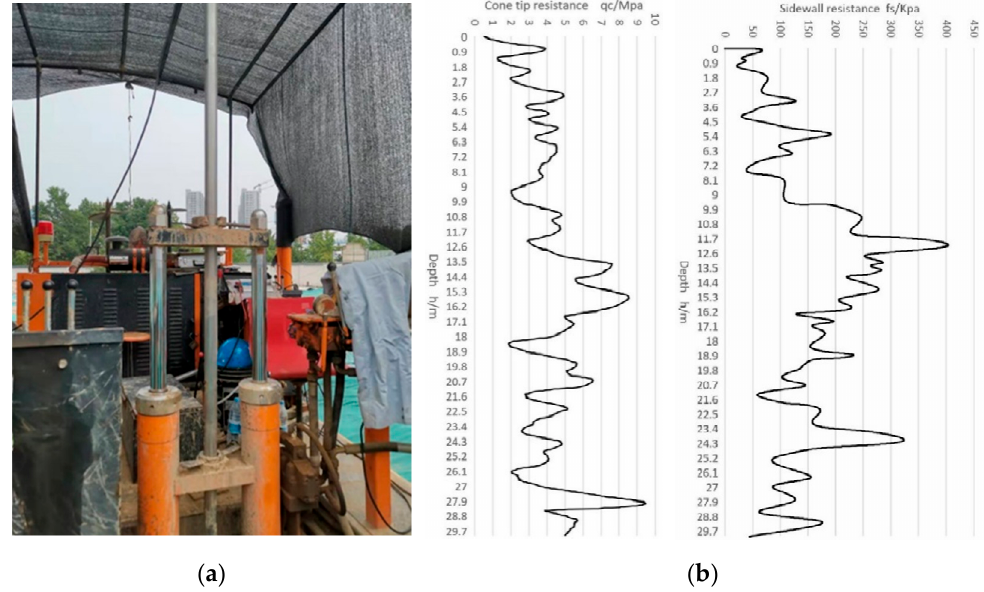
Figure 21. Experimental equipment and experimental data sheets: ( a ) hydraulic thrust device; ( b ) the curve diagram of the stress that the probe receives.